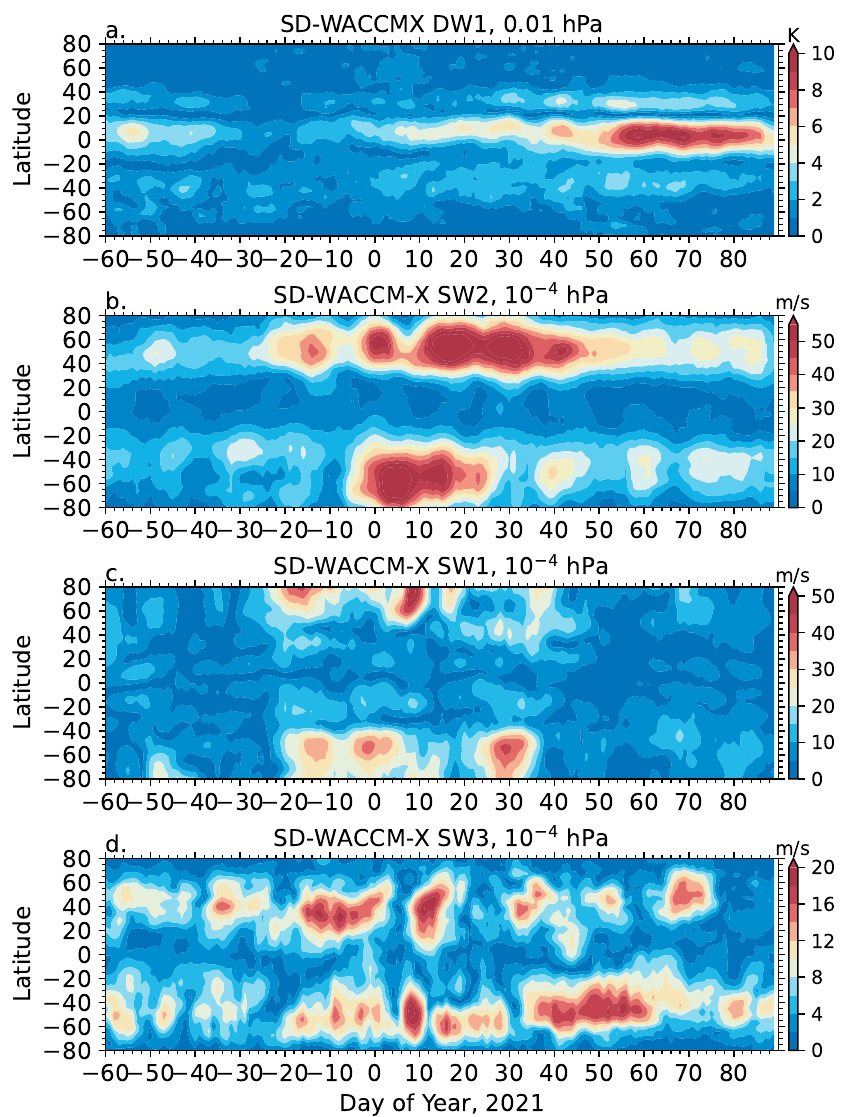
Figure 3. SD-WACCM-X amplitudes of the ( a ) DW1 at 0.01 hPa in temperature, ( b ) SW2 at 10 − 4 hPa in zonal wind, ( c ) SW1 at 10 − 4 hPa in zonal wind, and ( d ) SW3 at 10 − 4 hPa in zonal